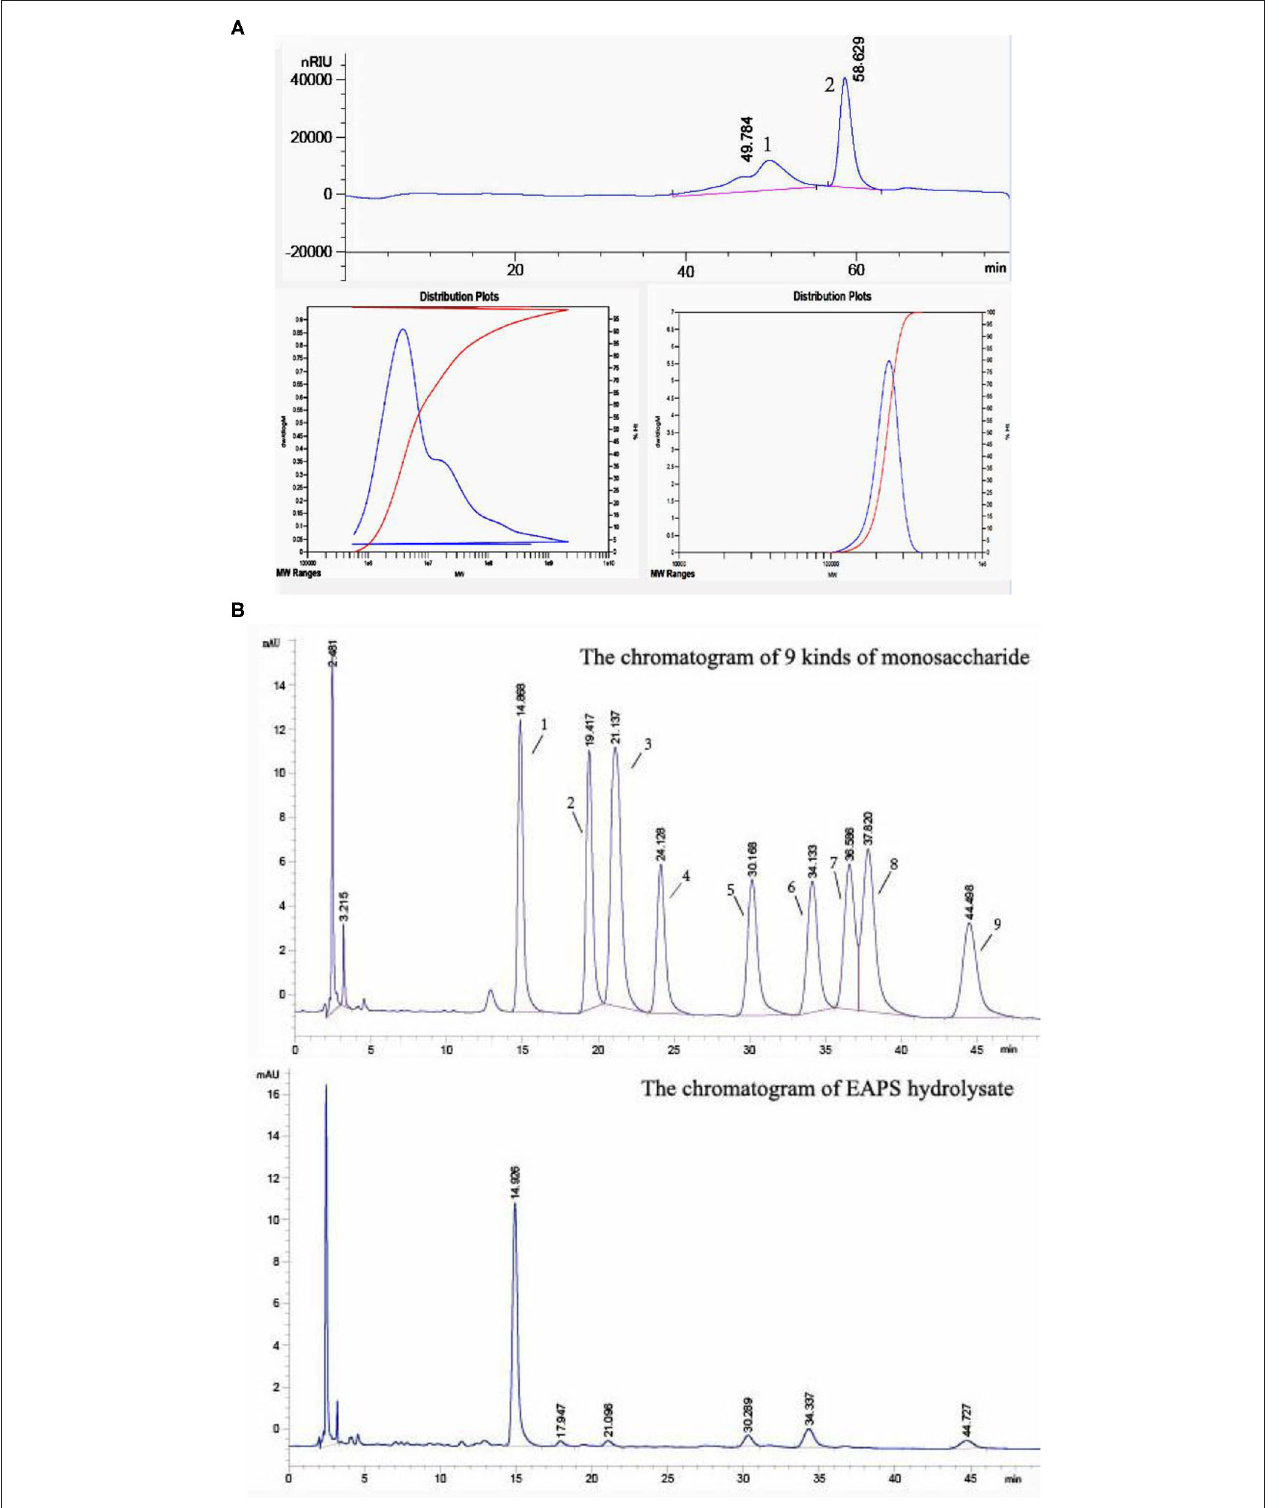
FIGURE 2 | Homogeneity, molecular mass, and monosaccharide composition determination of extracellular acidic polysaccharide (EAPS). (A) High-performance gel permeation chromatography of the EAPS. (B) The monosaccharide composition of EAPS from marine Rhodotorula sp. RY1801.